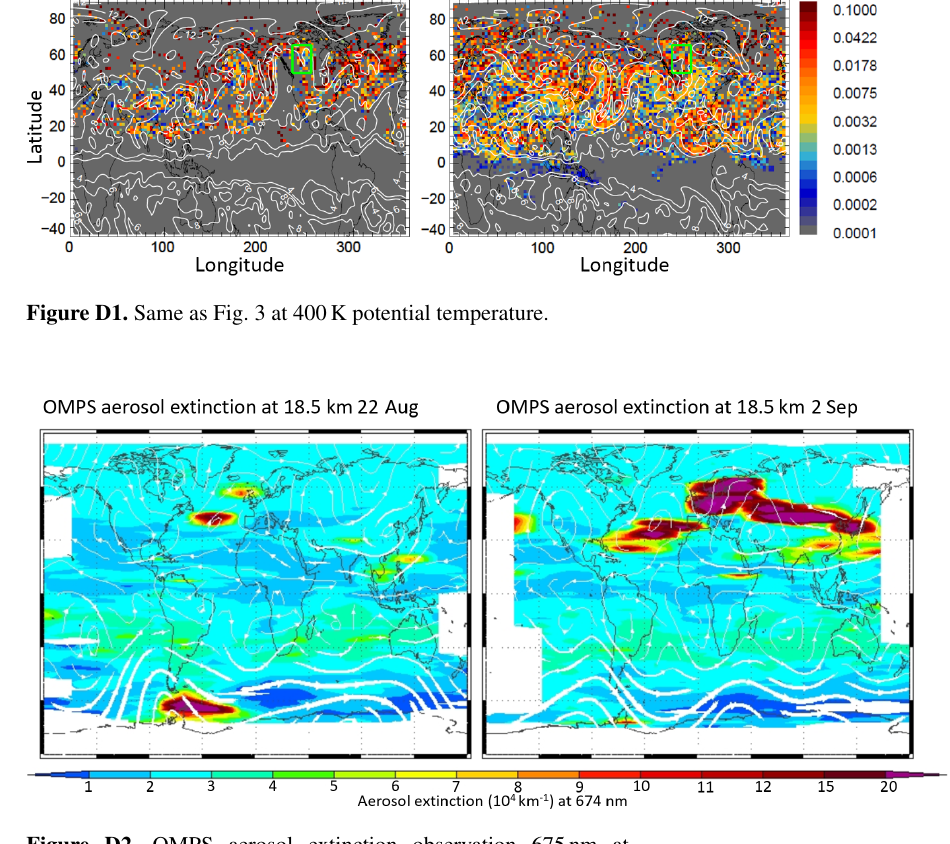
Figure D2. OMPS aerosol extinction observation 675nm at 18.5km altitude on 22 August and 2 September at 675nm. White lines are the MERRA